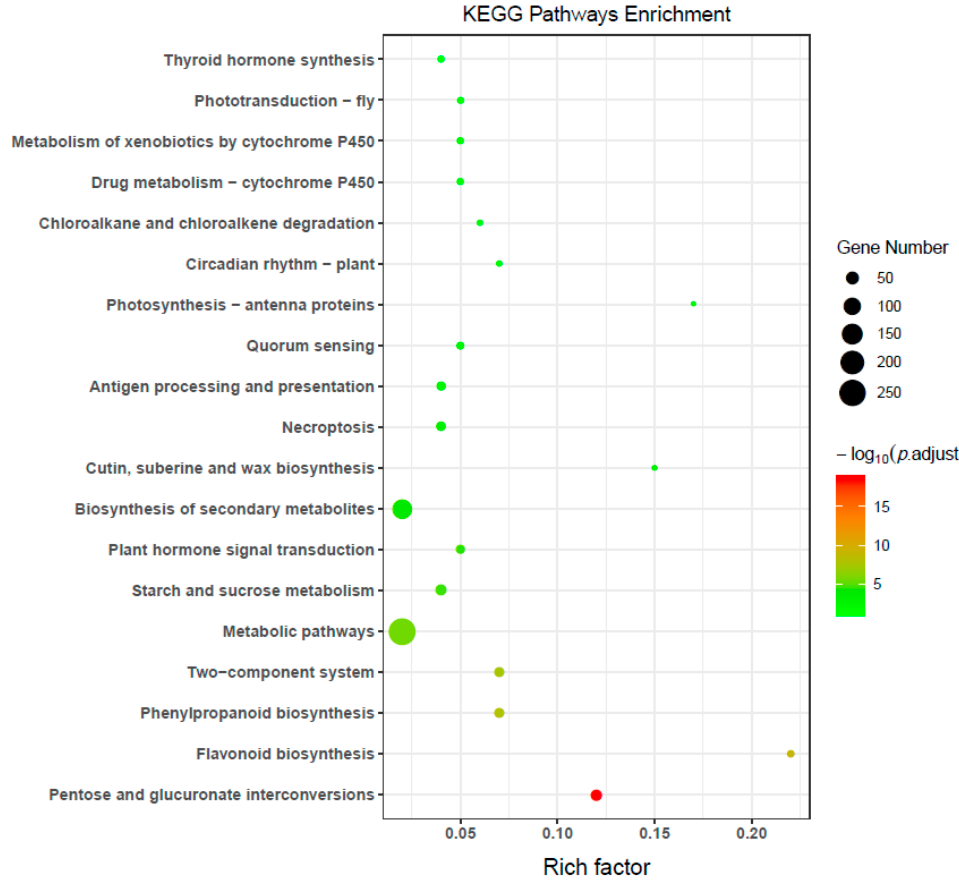
Figure 6. Kyoto Encyclopedia of Genes and Genomes (KEGG) enrichment analysis of differentially expressed genes (DEGs).